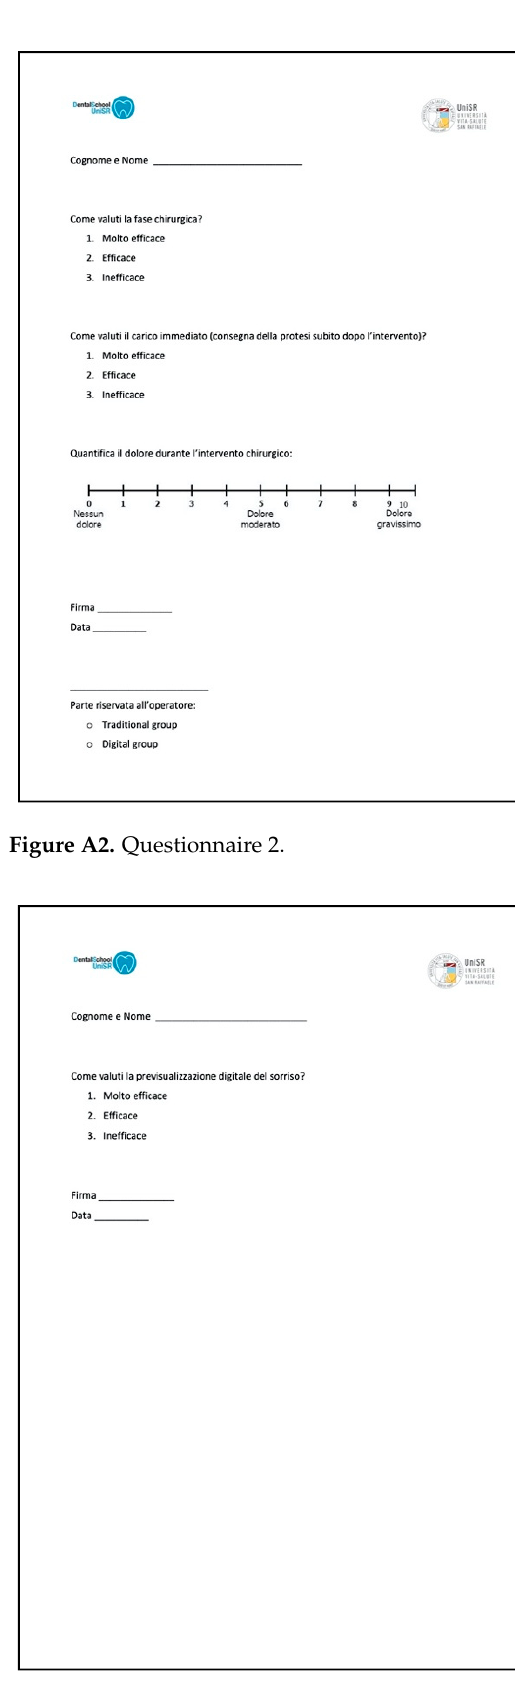
Figure A1. Questionnaire 1.